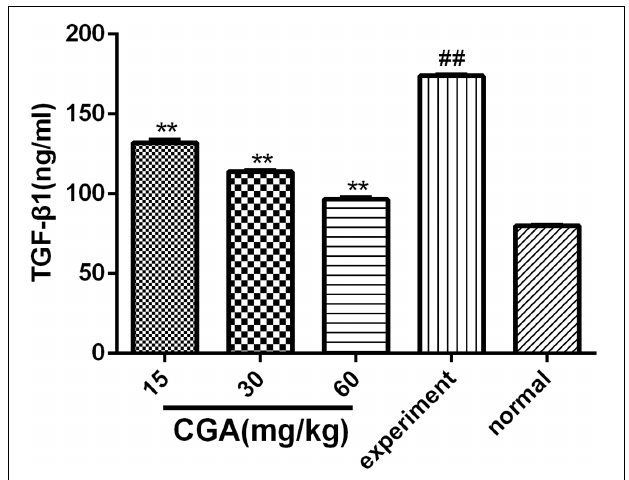
FIGURE 8 | Effect of CGA on the expression of TGF- β 1 in serum, and the level of TGF- β 1 was determined by ELISA. Data are shown as the means ± standard deviation. n = 10, ∗∗ P < 0.01 compared with the experimental group; ## P < 0.01 compared with the normal group, as determined by Student’s t